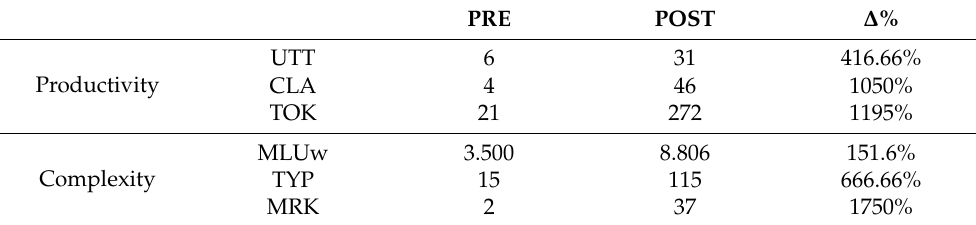
Table 6. Microstructure of Narrative Productivity and Microstructure of Narrative Complexity.